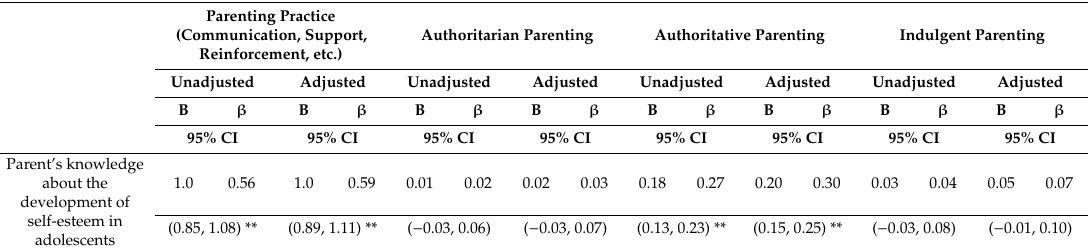
Table2. Linearregressionassociationbetweenparents’knowledgeaboutthedevelopmentofself-esteem in adolescents and their parenting practice. Parenting Practice (Communication, Support, Authoritarian Parenting Authoritative Parenting Indulgent Parenting Reinforcement, etc.) Unadjusted Adjusted Unadjusted Adjusted Unadjusted Adjusted Unadjusted Adjusted β β Parent’s knowledge about the development of self-esteem